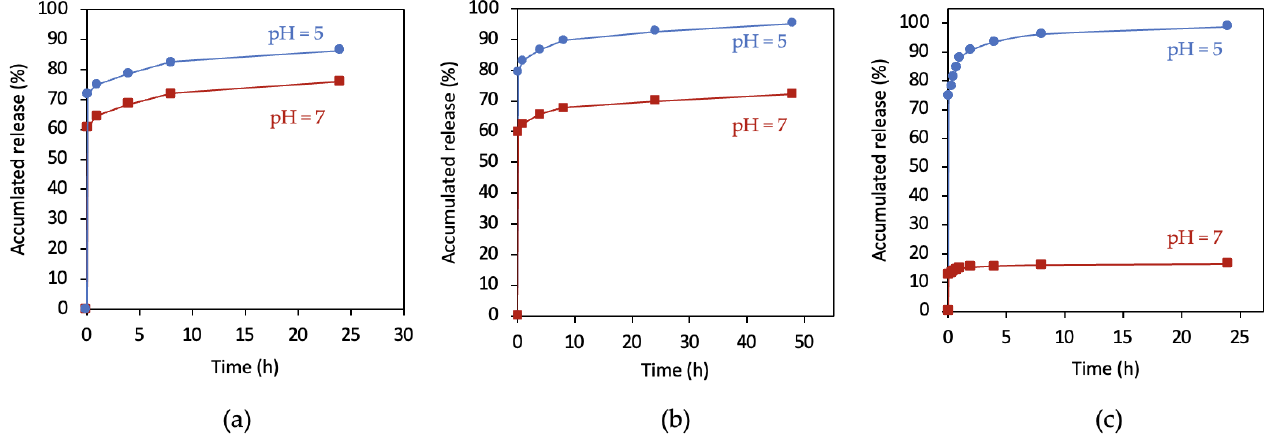
Figure 9. Release profiles of ZIF-8-encapsulated CIP in neutral and acid media: ( a ) CIP/ZIF (0.007 mg/mg); ( b ) CIP/ZIF (0.4 mg/mg); and ( c ) CIP/ZIF (2 mg/mg).